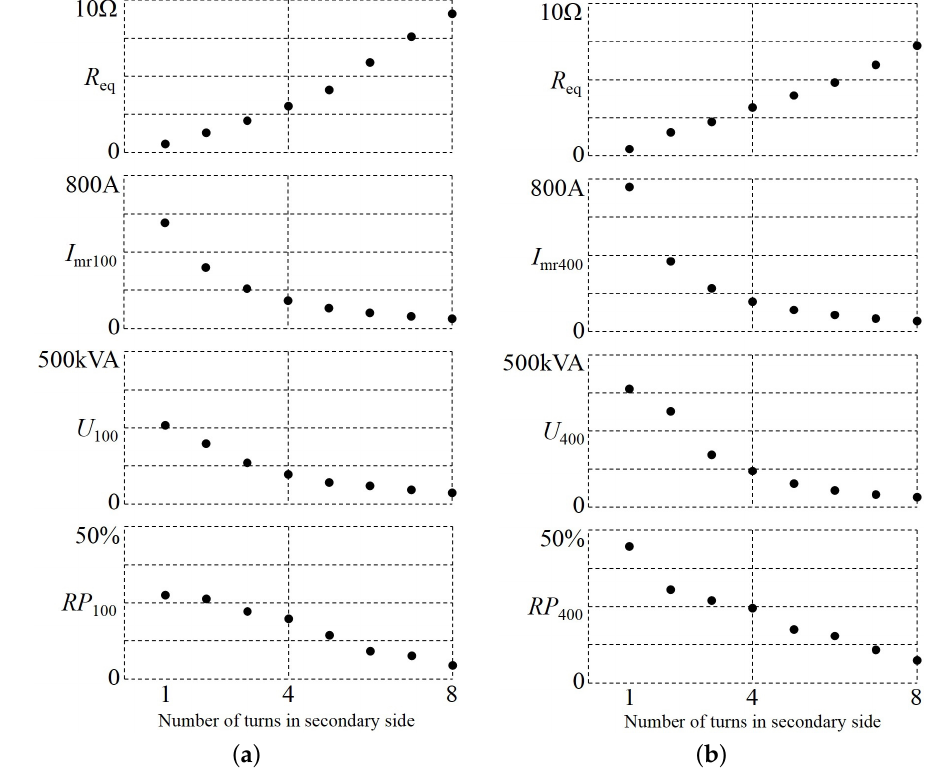
Figure 16. Relationship between the number of turns on the secondary side of the matching transformer and the proposed inrush current suppressor. ( a ) For the 100-kW SCIM; ( b ) For the 400-kW